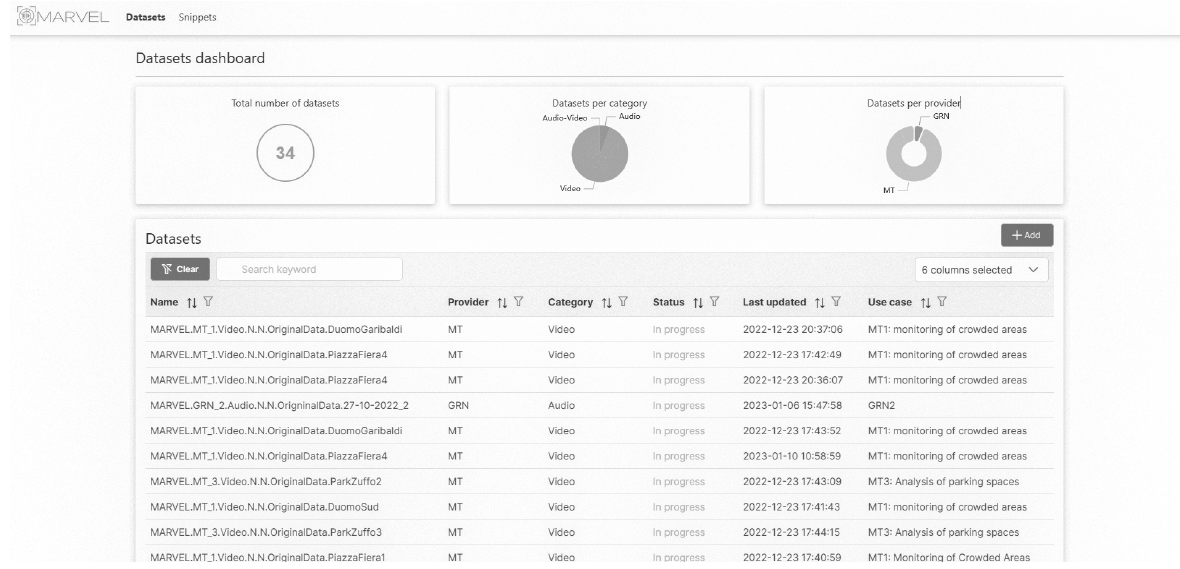
Figure 6. GUI: main dashboard (mock-up